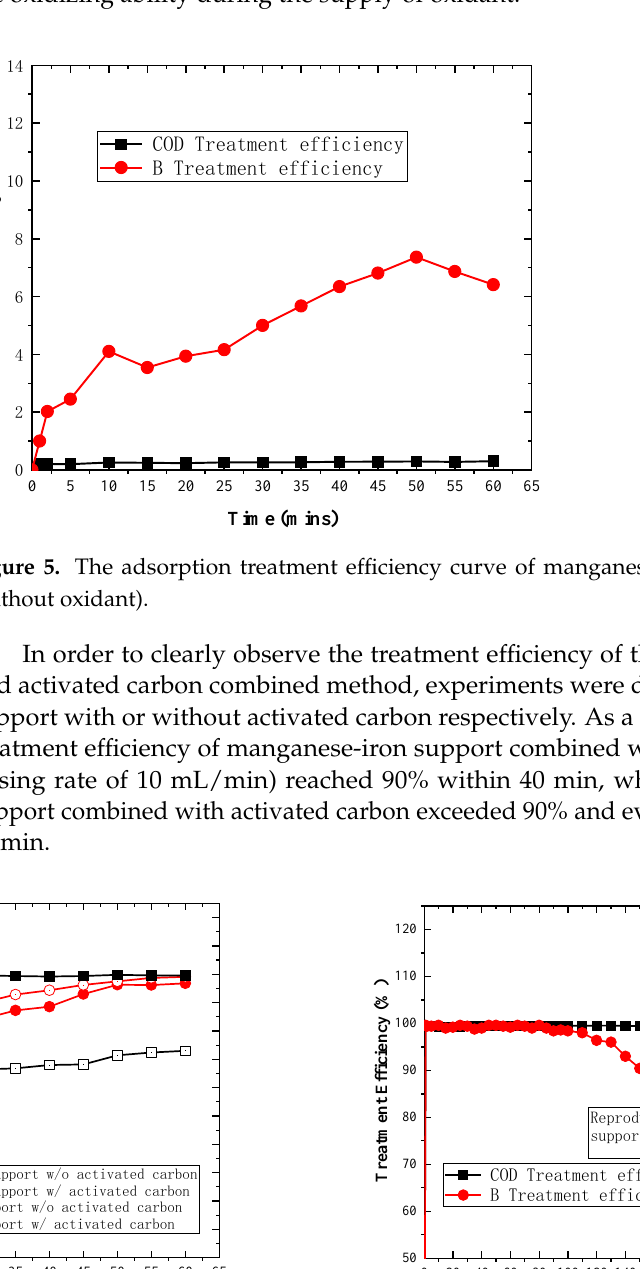
Figure 4. The adsorption efficiency and saturation test curves of activated carbon. ( A ) COD and Boron adsorption efficiency ( B ) COD and Boron treatment efficiency at 100 days.